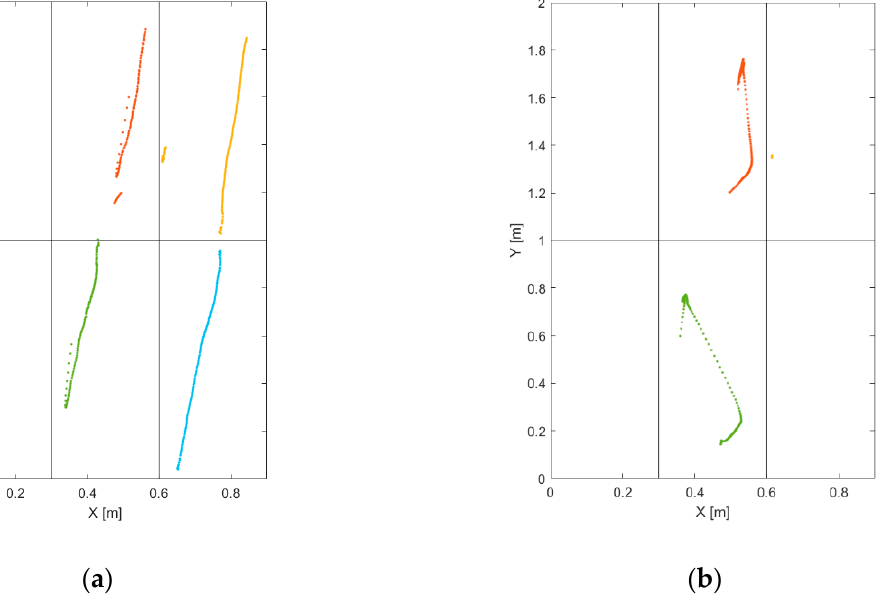
(cid:17) and ( b ) people extraction